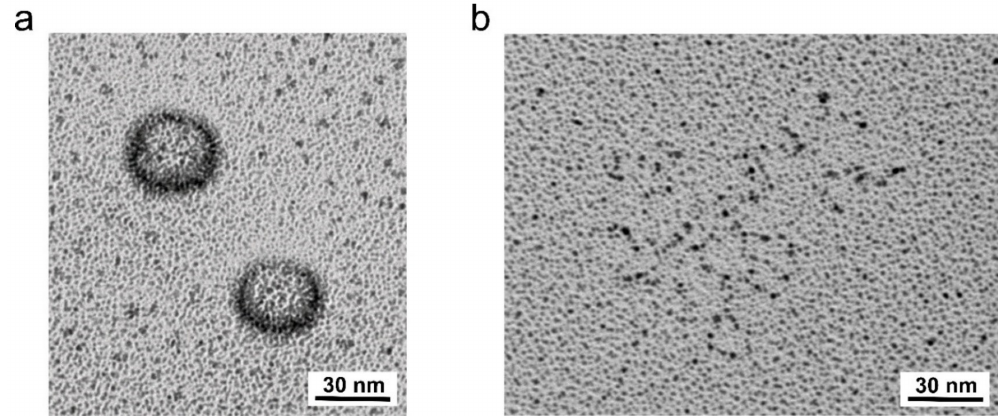
Figure 2. RV-A2 RNA morphology revealed by rotary shadowing electron microscopy. Purified RV-A2 in 100 mM potassium phosphate buffer (pH 7.4) was incubated with proteinase K for 12 h at 4 ◦ C and divided into two aliquots. One was kept at 4 ◦ C ( a ); one was kept for 10 min at 90 ◦ C followed by slow cooling ( b ). The samples were mixed 1:1 with 200 mM ammonium acetate, 60% ( v / v ) glycerol, sprayed onto freshly cleaved mica chips, and coated with 0.6 nm platinum at an angle of 7 ◦ under high vacuum. Replicas were floated onto carbon-coated grids and imaged under an FEI Morgagni transmission electron